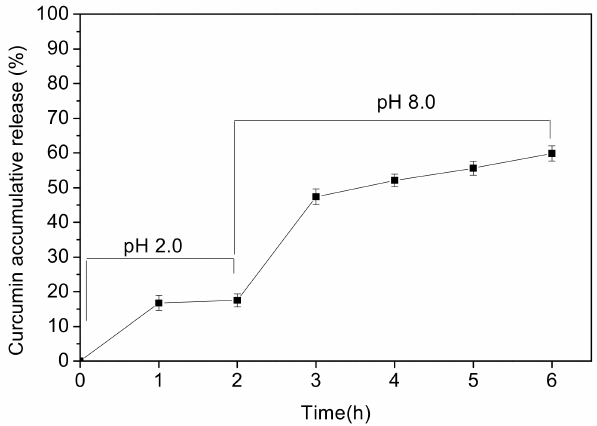
Figure 5. Drug-releasing profiles. Curcumin-loaded PECs were placed into dialysis bags (molecular weight cutoff: 6–8 k) (M.W.C.O.: 6–8 k), which were immersed to an ethanol/deionized water (1:1, v / v )